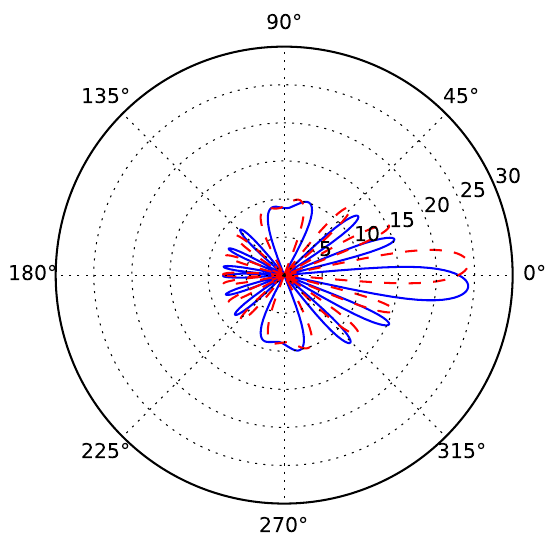
Figure 10. The left and right beam patterns for an amplitude comparison monopulse receiver squinted for angle measurement, units are in